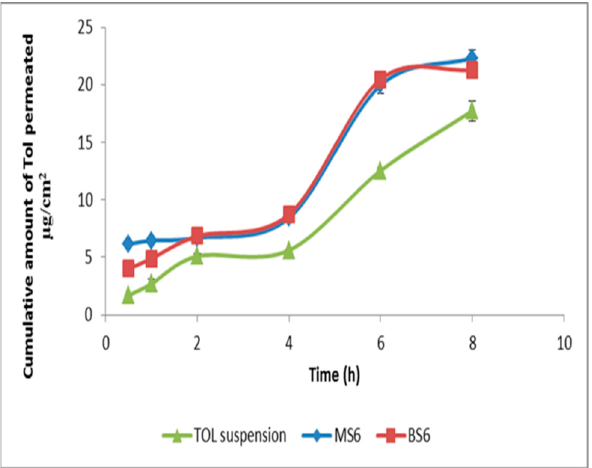
Figure 8. Ex vivo corneal permeation profile of TOL-cosolvent spanlastics (MS6) and basic spanlastics (BS6) compared to TOL suspension. Table 7. Ex vivo corneal permeability parameters of TOL-cosolvent spanlastics (MS6) and basic spanlastics (BS6) compared to a drug